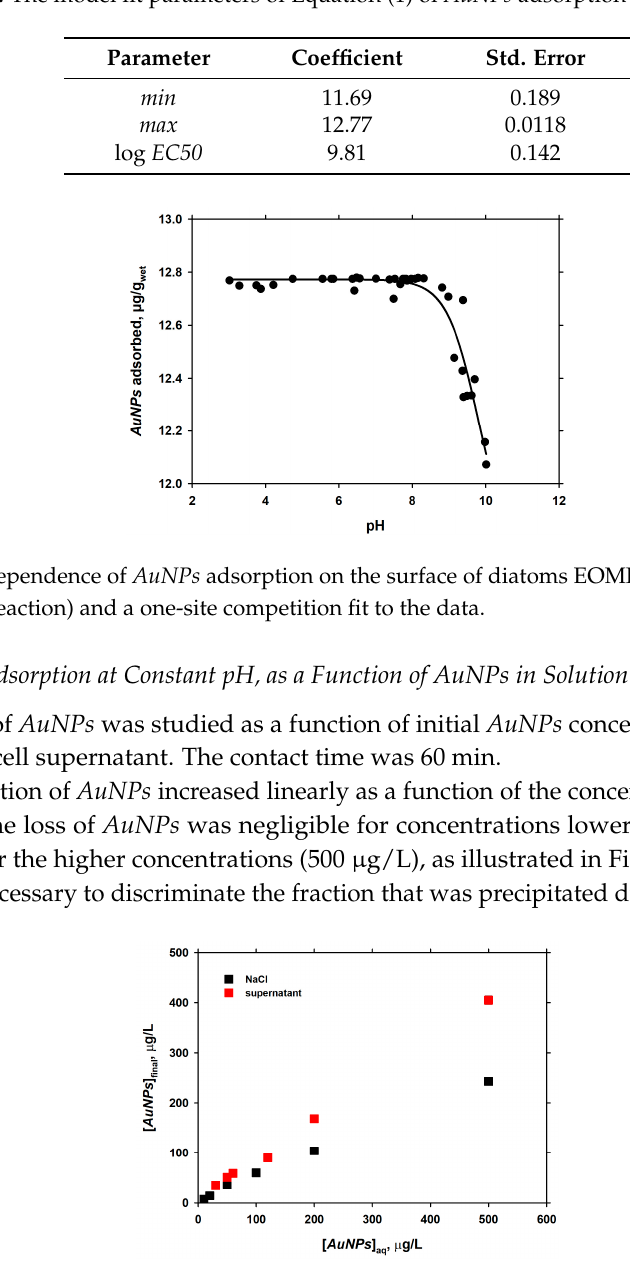
Figure 6. Stability of AuNPs in 0.01 M NaCl and cell supernatant solution for 0.2 and 0.5 g wet /L of diatoms. The loss of AuNPs in blank experiments is 45% smaller in cell supernatant compared to the inert electrolyte (0.01 M NaCl). The error bars are within the symbol size unless shown.